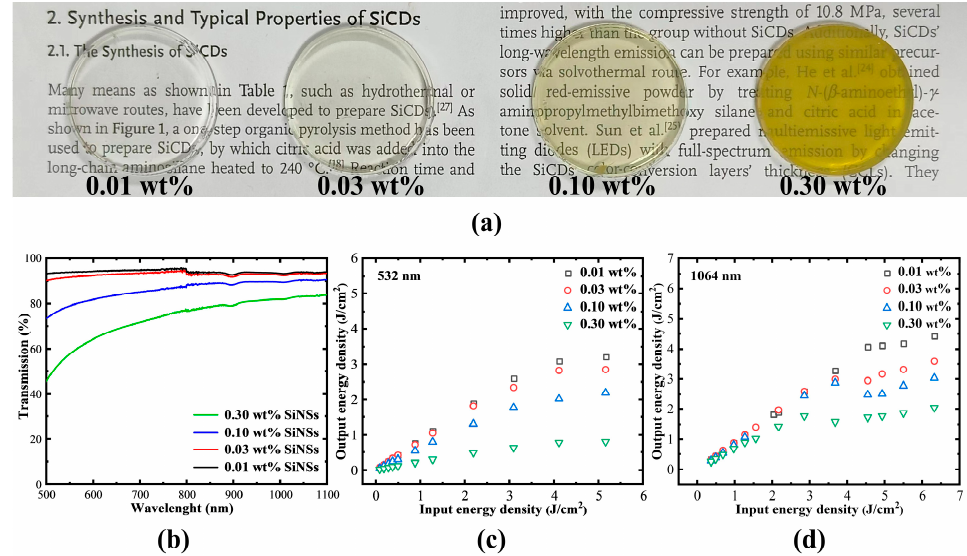
Figure 5. Nonlinear optical properties of siloxene nanosheet hybrid gel glasses. ( a ) Photographs (background text content [34]) and ( b ) visible-near IR spectra of 0.01, 0.03, 0.10, and 0.30 wt% siloxene nanosheets hybrid gel glasses; ( c , d ) optical limiting responses of siloxene nanosheet hybrid gel glasses under 532 nm and 1064 nm. Table 3. F ON , R OL, and T linear of the various siloxene nanosheet hybrid gel glasses. Samples